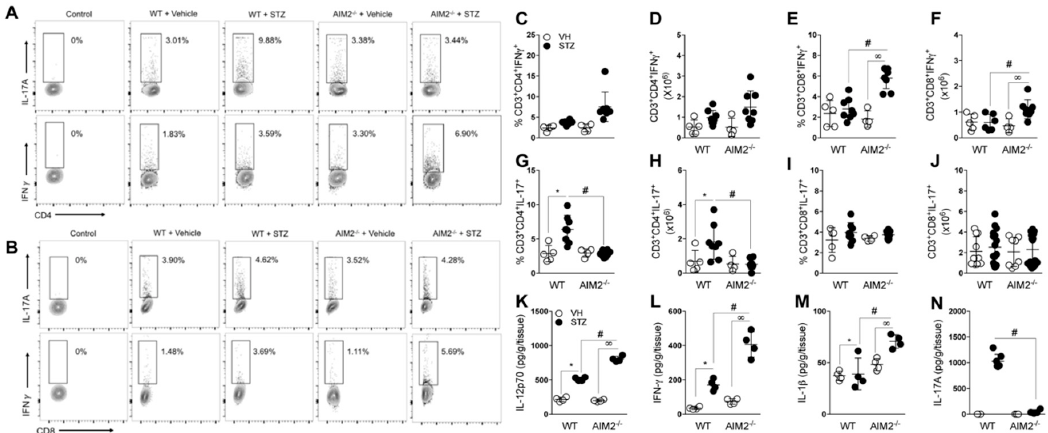
Figure 3. Deficiency of AIM2 increases Th1 and Tc1 populations in PLNs during T1D. Cells from the PLNs of the WT and AIM2 − / − mice were harvested at 15 days after the vehicle (VH) or STZ administration and assessed for extracellular (CD3, CD4 and CD8) and intracellular (IL-17 and IFN- γ ) molecules, with a minimum of 2 × 10 6 cells per sample. ( A , B ) Representative dot plot of CD4 + IL-17 + (Th17), CD8 + IL-17 + (Tc17), CD4 + IFN- γ + (Th1), and CD8 + IFN- γ + (Tc1) cells in the PLNs of the WT and AIM2 − / − mice, after the STZ injections. ( C – J ) Percentage and absolute numbers of CD4 + IFN- γ + (Th1), CD4 + IL-17 + (Th17), CD8 + IL-17 + (Tc17), and CD8 + IFN- γ + (Tc1) cells in the PLNs of the WT and AIM2 − / − mice, after 0, 7 and 15 days of the STZ injections. ( K – N ) Protein levels of IL-12p70, IFN- γ , IL-1beta and IL-17 cytokines, assessed by ELISA in the pancreatic tissue of the WT and AIM2 − / − mice, after 15 days of STZ or vehicle injections. The values are expressed as the mean ± SD. The results were considered statistically significant when p < 0.05 (*; #, ∞ ). N = 3–6 animals per group. Significant di ff erences between the groups were determined by one-way ANOVA, followed by Tukey’s multiple-comparison